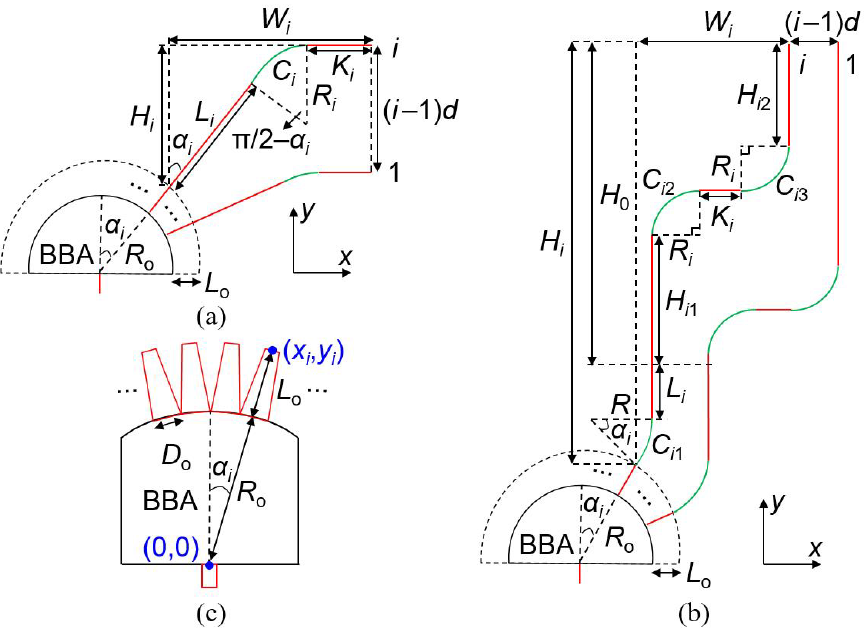
Figure 3. ( a , b ) Geometric structures with ( a ) one arc and ( b ) three arcs in each waveguide for designing WSLs with large and small length differences, respectively. ( c ) A BBA with one input waveguide and multiple output tapers.